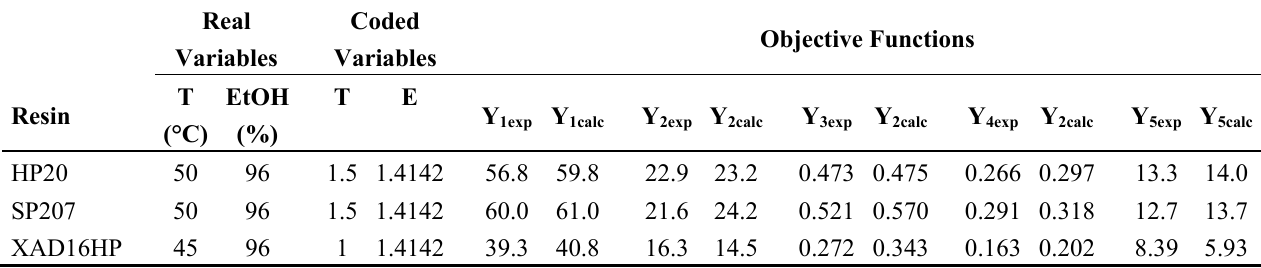
Table 6. Comparison between experimental and calculated values of the objective functions at the optimal conditions.